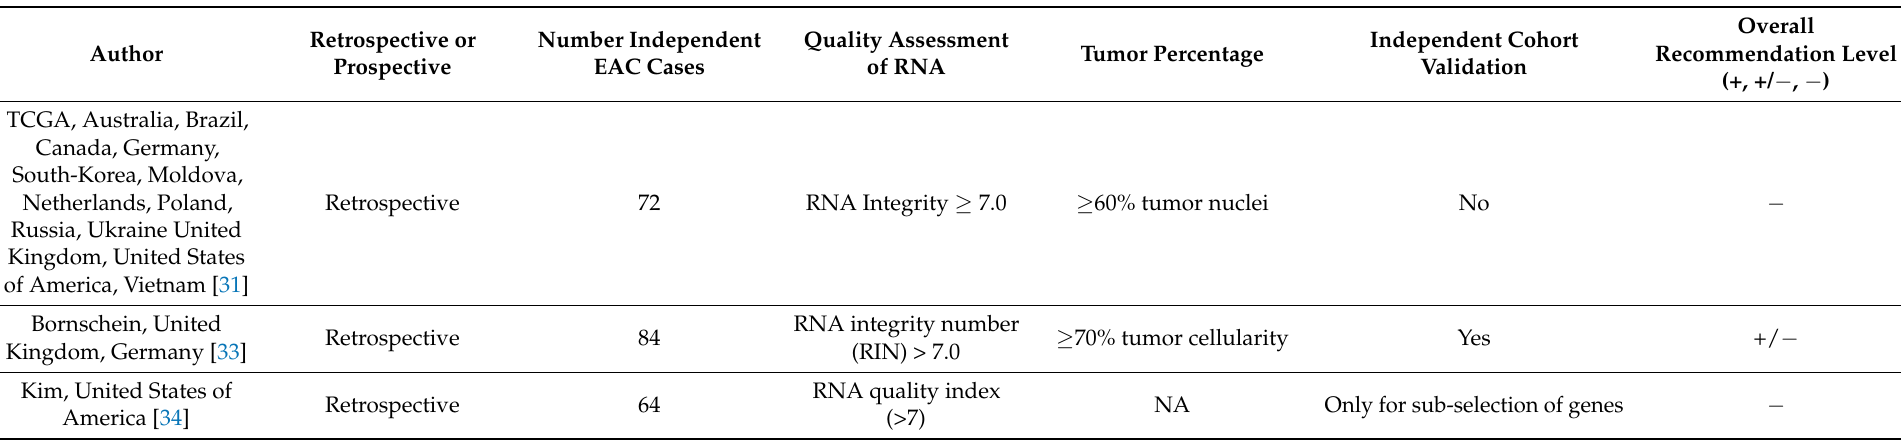
Table 3. Quality assessment of studies on transcriptomic analyses to identify distinct subtypes of